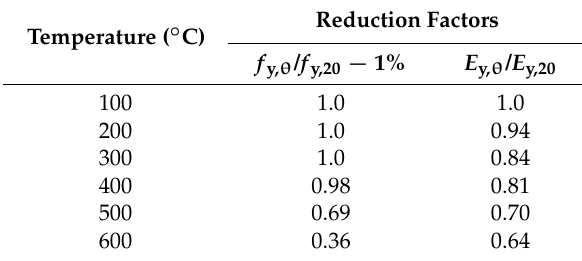
Table 4. Reduction factors for yield strength and modulus of